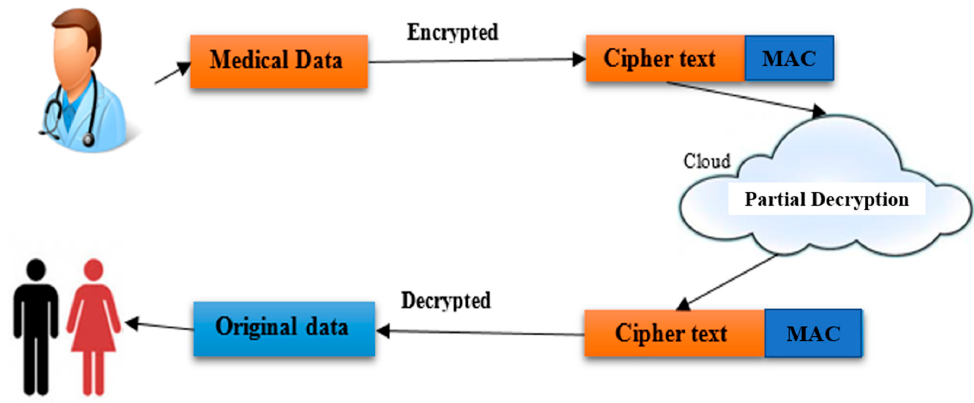
Figure 2. Architectural overview of the proposed system. MAC: message authentication code.